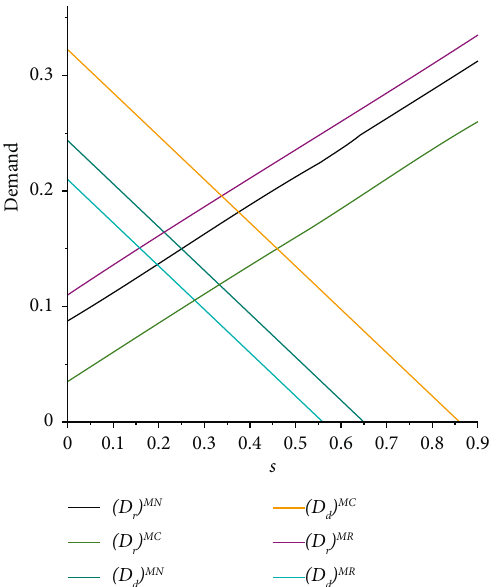
Figure 8: Effect of s on optimal demand.